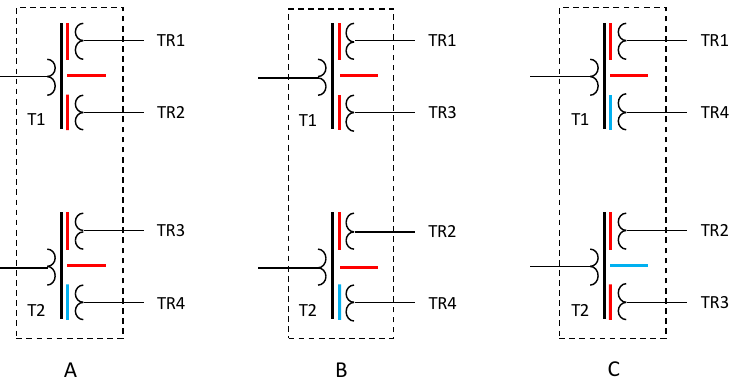
Figure 2. Gate driver power transmission configurations with a single transformer for each device, with CS and CD arrangements .